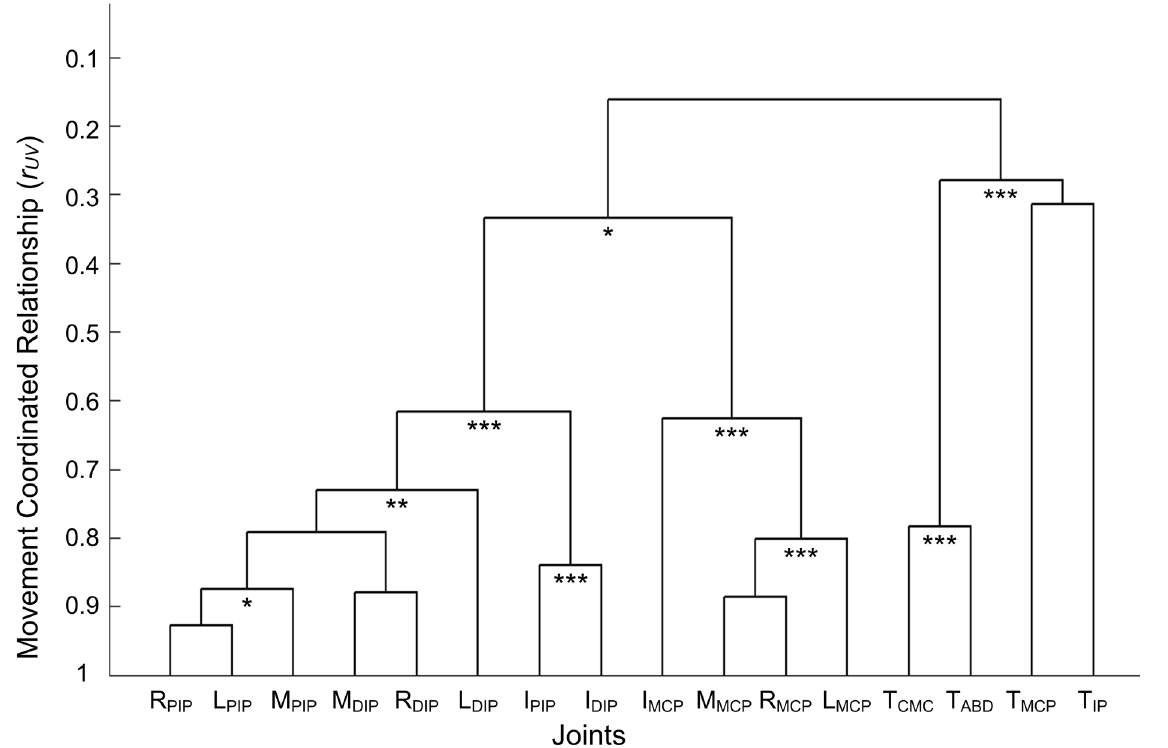
Fig 6. Dendrogram of the clustering of joints. This graphically shows the network of movement-coordinated relationships among the joints of the human hand. The lower branch nodes of the tree indicate better-coordinated relationships between the joints under the two branches. The significances of clustering are marked with * (p < 0.05), ** (p < 0.01) and *** (p < 0.001) under the